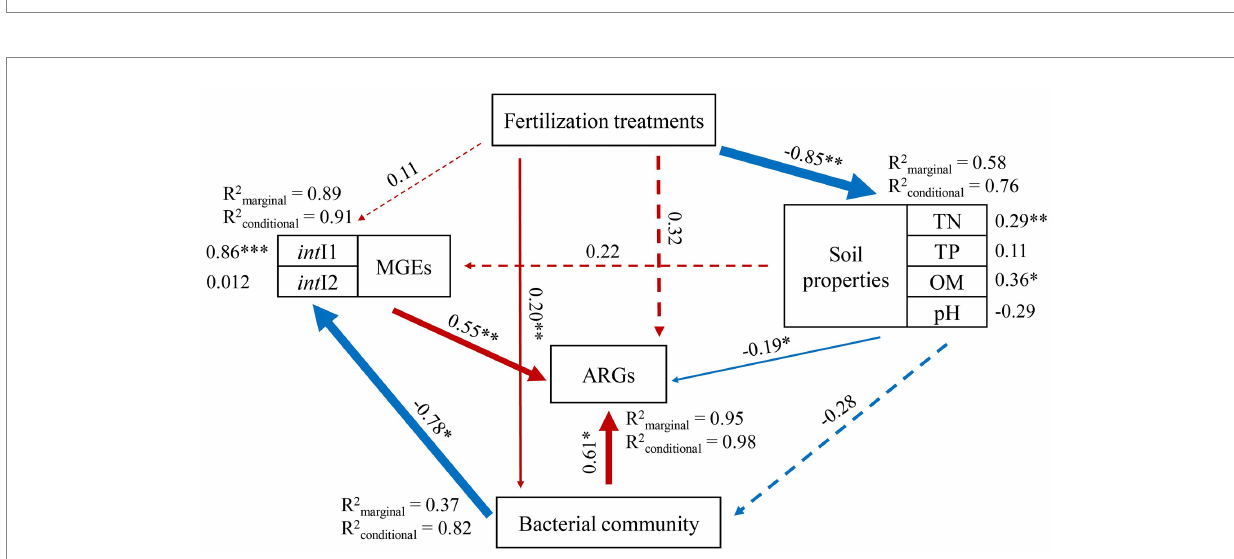
FIGURE 7 Structural equation models (SEMs) showing the effects of fertilization treatment, soil properties, bacterial community, MGEs and ARGs abundance in paddy-upland soil. Red and blue arrows represent positive and negative relationships, respectively. Solid and dashed arrows denote, respectively, significant and nonsignificant relationships. R 2 represent the proportion of variance explained by all predictors. The hypothetical model fits the data well: Fisher’ C = 19.29, p = 0.37, df = 10, AIC = 59.29, BIC = 60.88. Significance levels of each predictor were * p < 0.05, ** p < 0.01 and *** p <